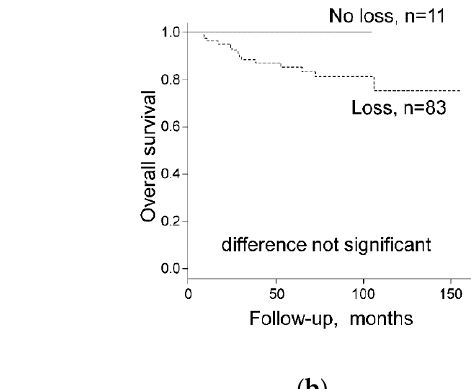
and ( b ) Loss of any chromosome among chromosome 1, 2, 6, 10, 13, 17, or 21 (Loss versus No loss) in